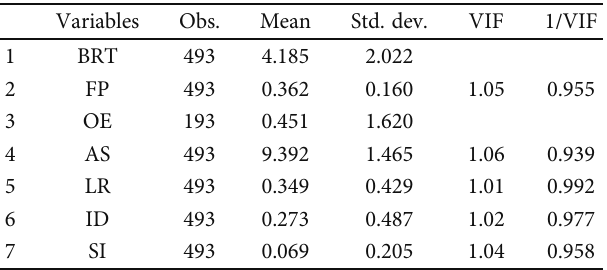
Table 5: Consolidated path analysis